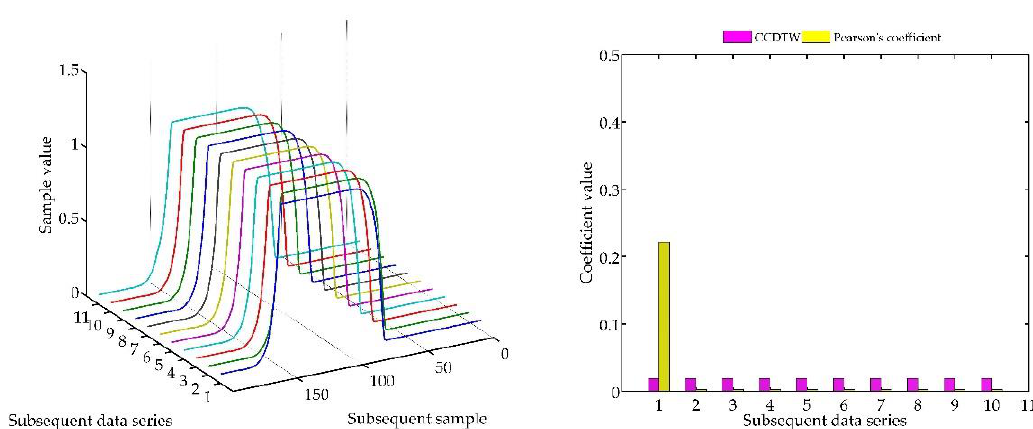
Figure 13. Simulation results achieved for data shifted by +10 samples for the first series (blue line) for r ampl = 2.